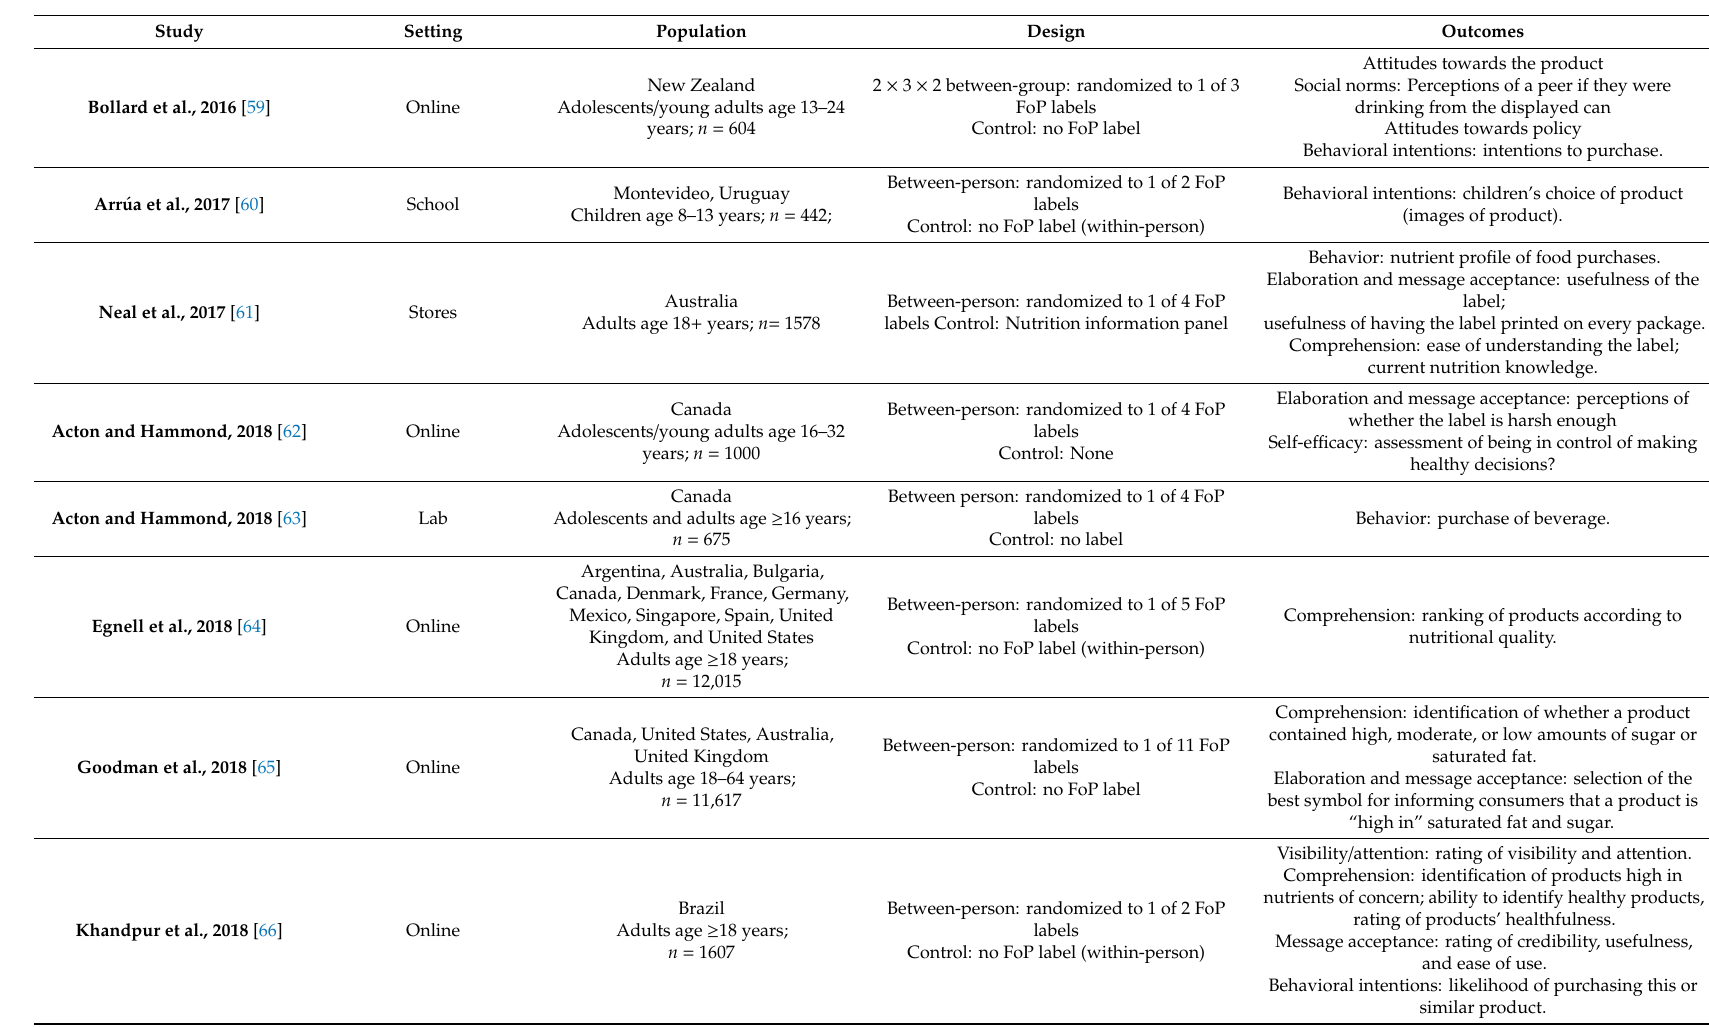
Table 2. Study information: population, design, and